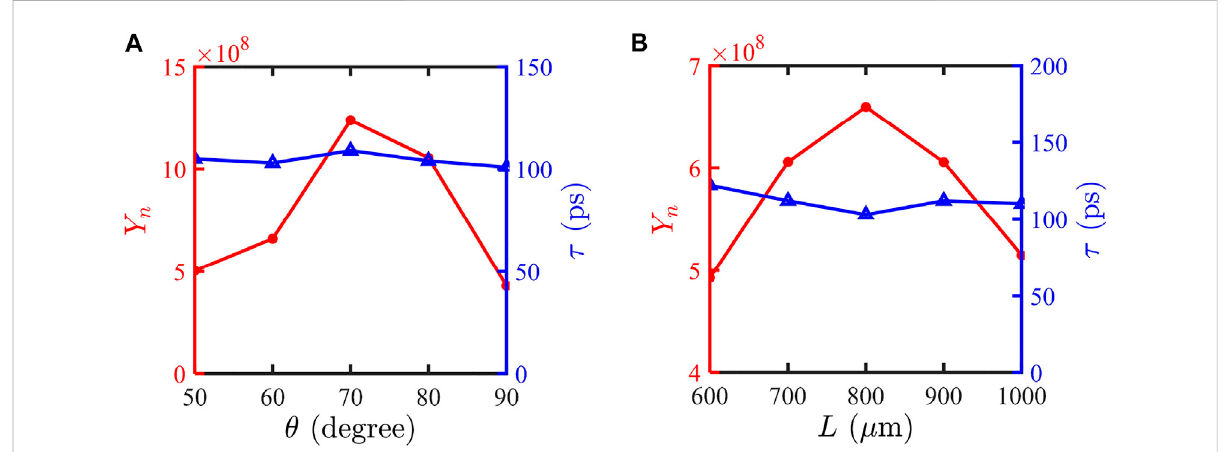
FIGURE 8 Yield (red-circle lines) and duration (blue-triangle lines) evolve as the cone angle (A) and the distance of separate cone tips (B) . The distance of cone tips is fi xed as L (cid:2) 800 μ m in (A) , and the half-opening angle is fi xed as θ (cid:2) 60 ° in (B) .